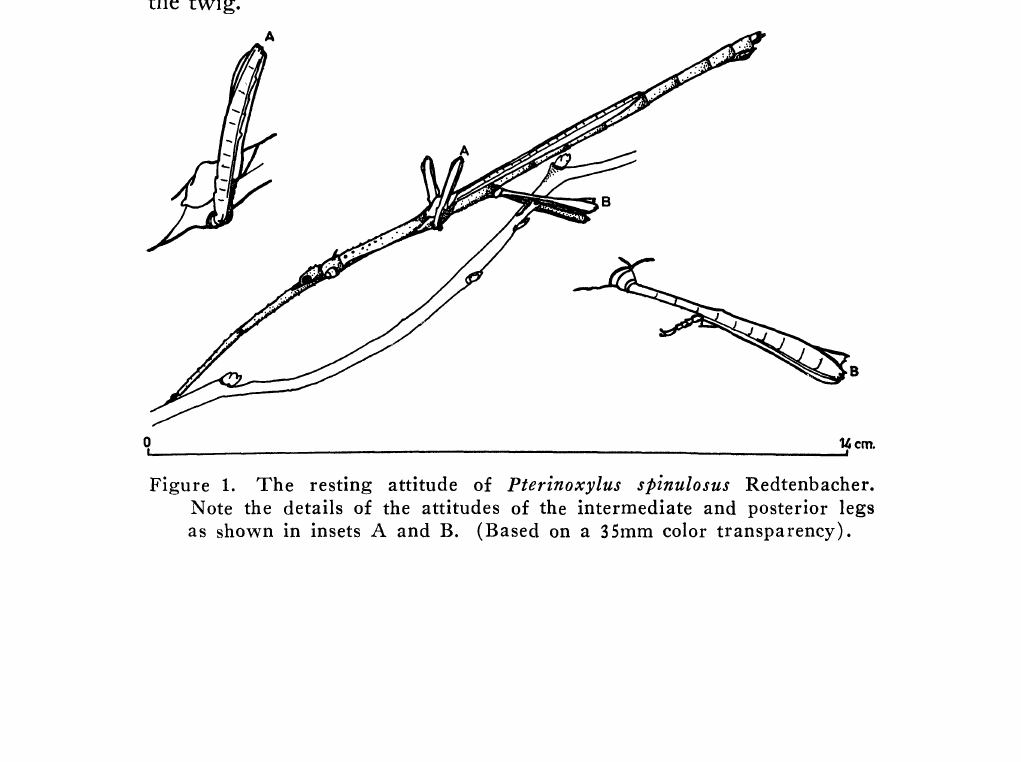
Figure 1. The resting attitude of Pterinoxylus spinulosus Redtenbaeher. Note the details o the attitudes of the intermediate and posterior legs as shown in insets A and B. (Based on a 35ram color